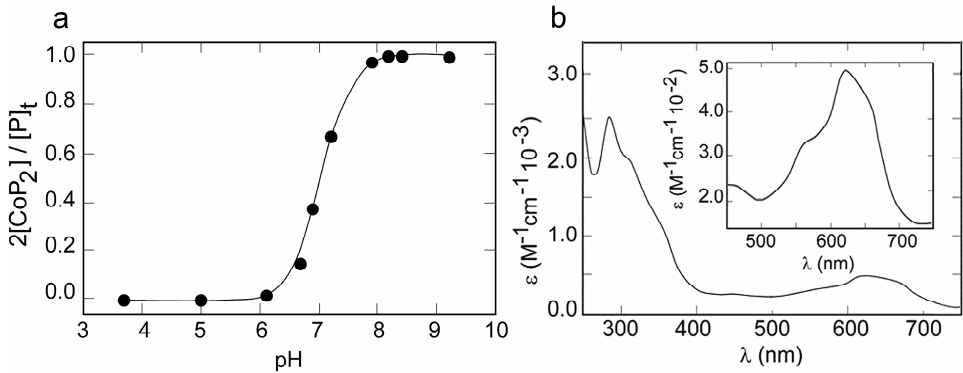
Figure 2. ( a ) pH titration of Co(II)-METP3 complex in the presence of 10% excess of Co(II). ( b ) UV- visible absorption spectrum of Co(II)-METP3 complex (10 mM TRIS buffer pH 8.2).